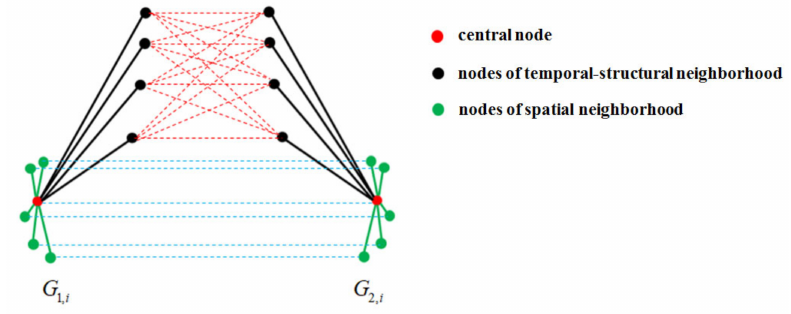
Figure 3. Measurement of a temporal-spatial-structural graph